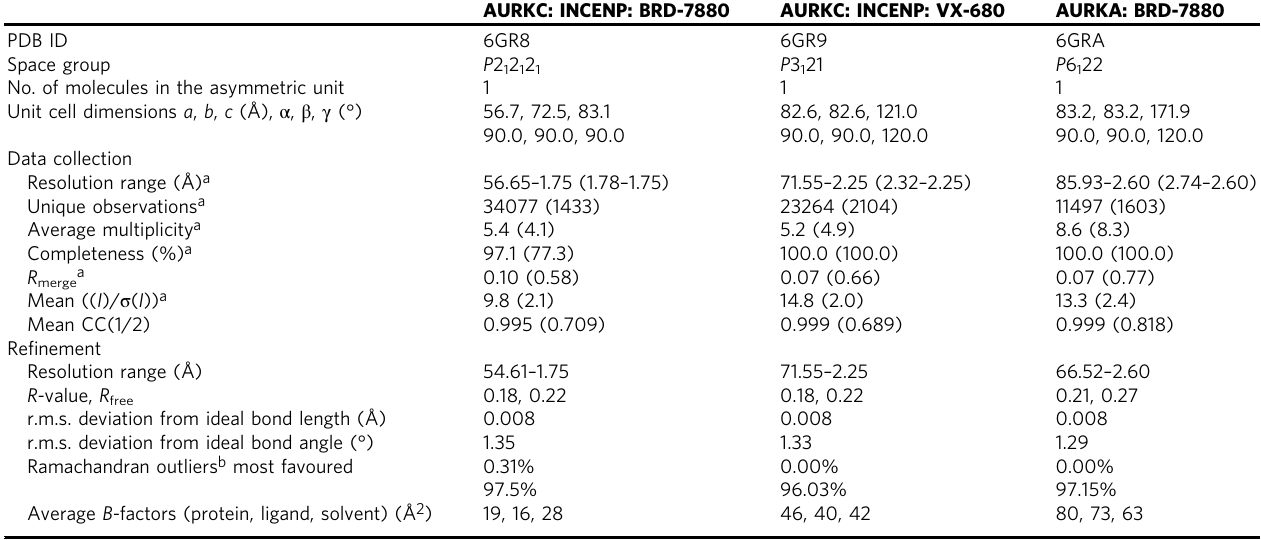
Table 1 Data collection and re fi nement